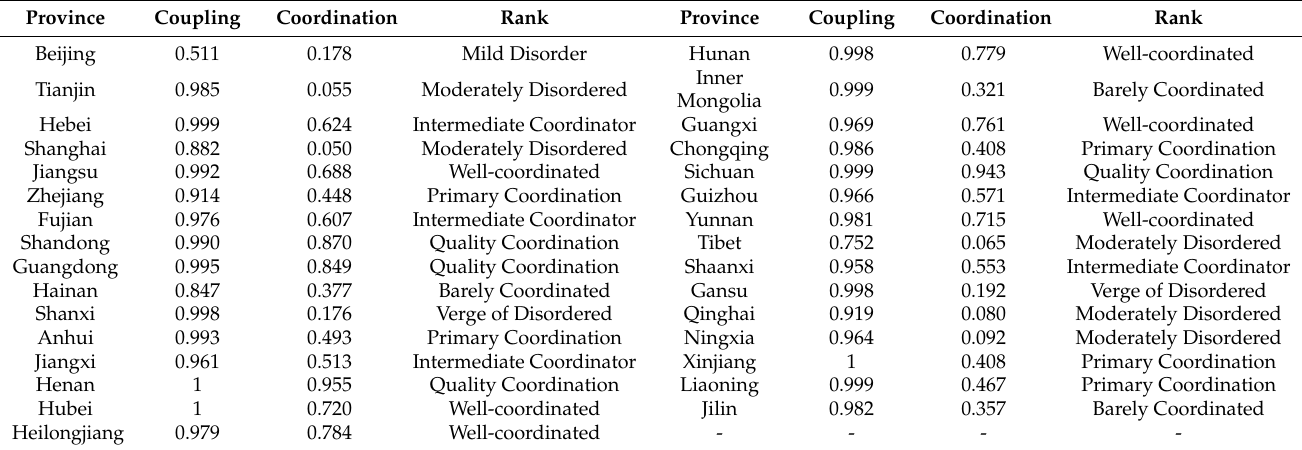
Table 3. 2020 agricultural economy and environment coupling coordination